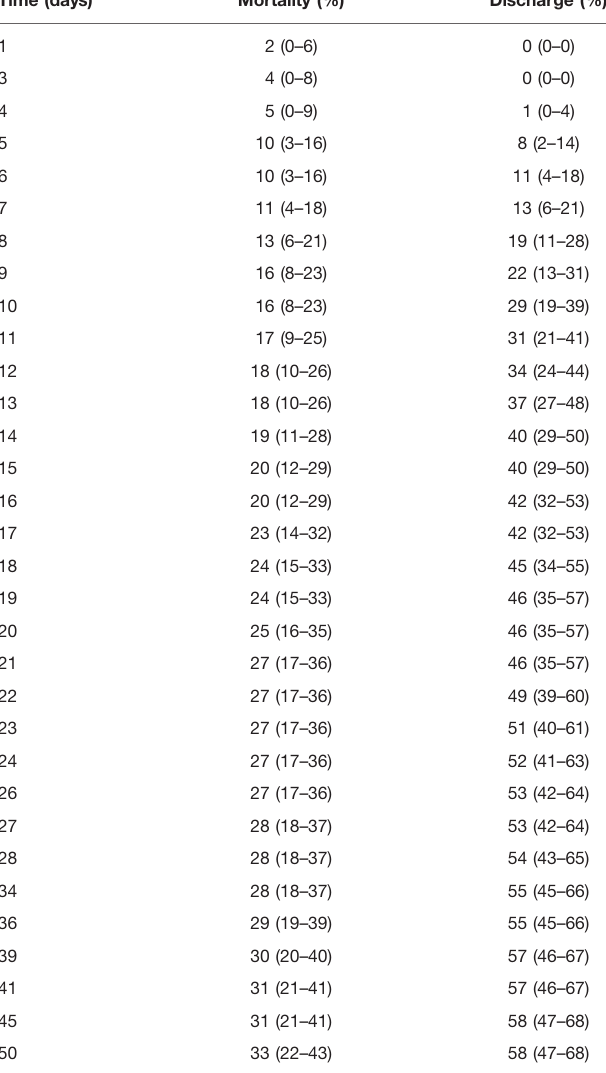
TABLE 7 | Cumulative incidence of in-hospital mortality and discharge by time since surgery estimated by using the Aalen – Johansen estimator with 95% con fi dence